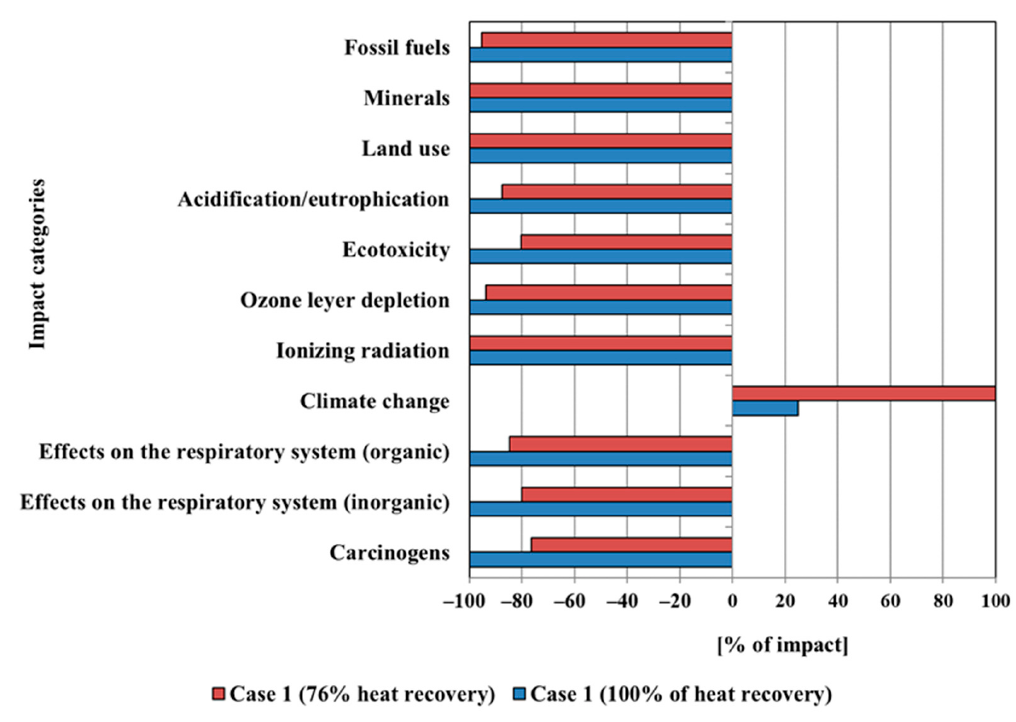
Figure 7. The comparative life cycle analysis results between 1 MWh of electricity generation from biogas obtained in Case 1 with 76% and 100% thermal energy utilization for individual impact categories under the Eco–Indicator 99 method (characterization).